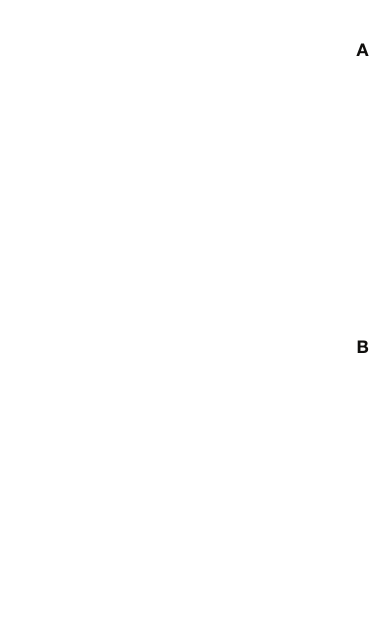
FIGURE 1 | Characteristics and differences of m 7 G-related genes in The Cancer Genome Atlas-lung adenocarcinoma (TCGA-LUAD) cohort. (A) The fl owchart of this study. (B) Heatmap for differences in m 7 G- related gene expression between LUAD tumor and normal tissues. (C) The PPI network between 24 differentially expressed m 7 G-related genes ( p < 0.05) and the hub genes network. (D) The correlation in m 7 G- related gene expression. (E) Genetic mutation frequency and types of m 7 G-related genes. * p < 0.05, ** p < 0.01, *** p <